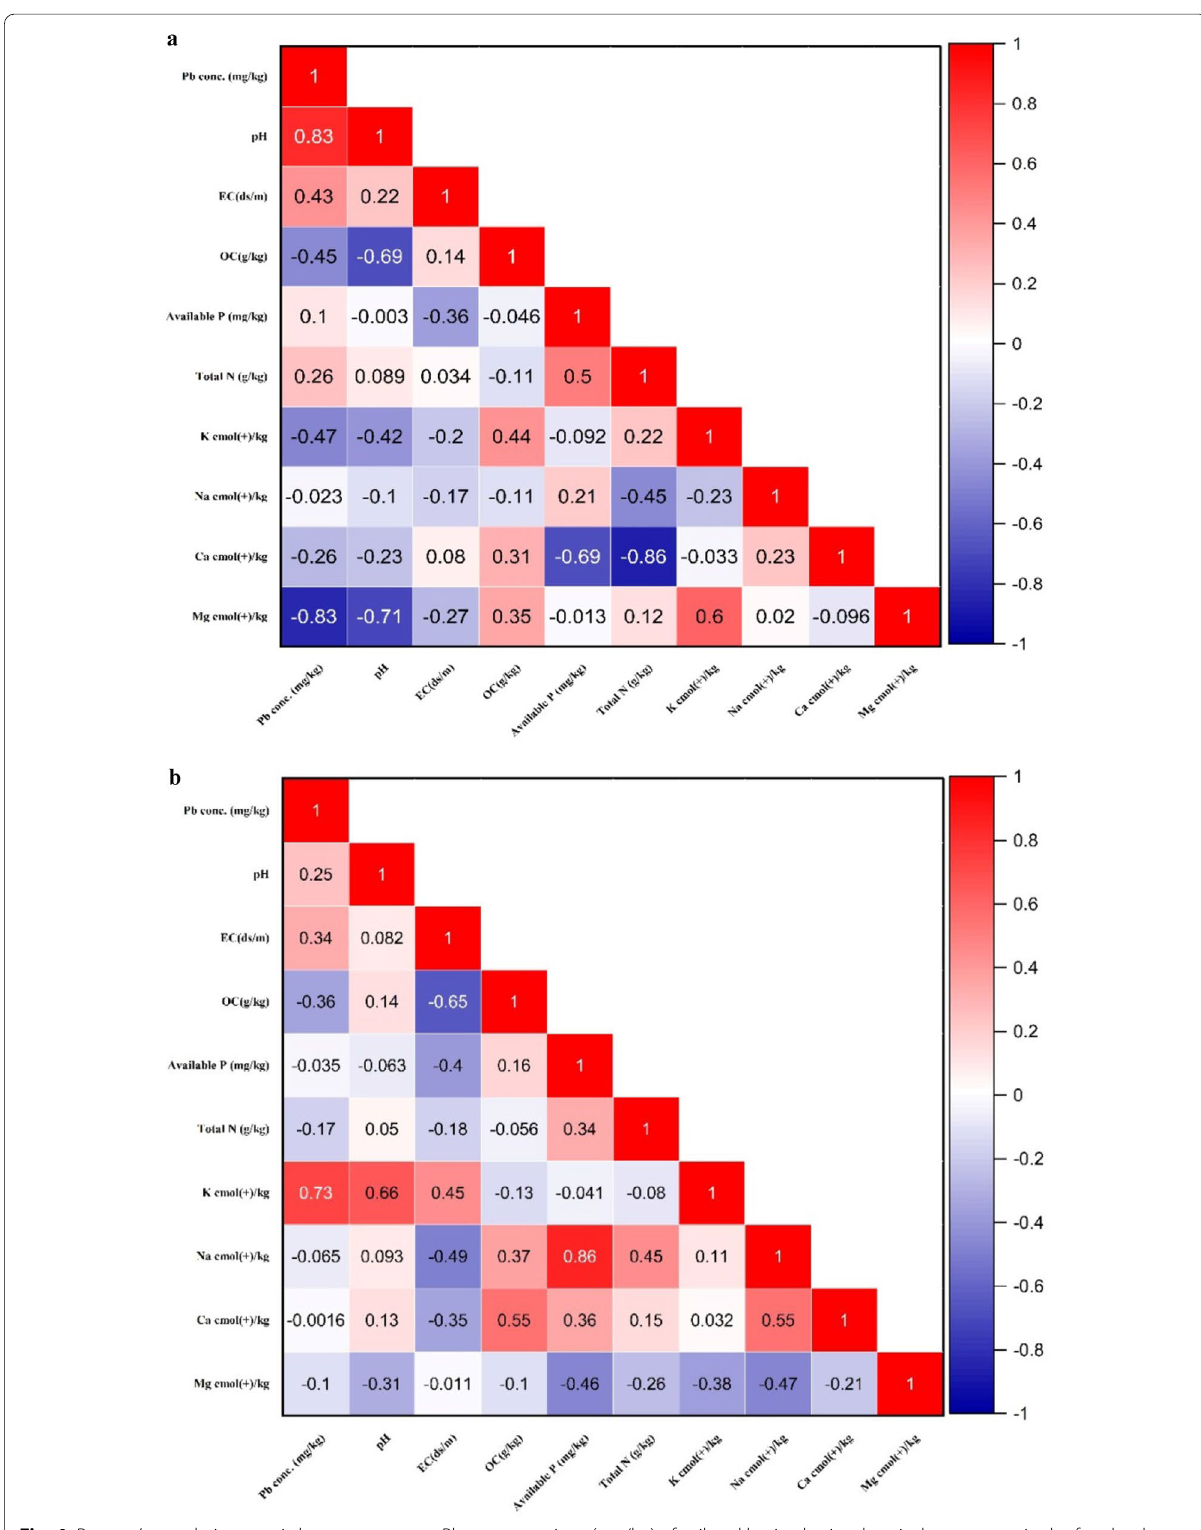
Fig. 4 Pearson’s correlation matrix between average Pb concentrations (mg/kg) of soil and basic physicochemical parameters in the farmland across the Abare sites, Anka Local ( a ), Bagega sites, Anka local ( b ), and Dareta sites, Anka local ( c ) Governments, Zamfara State,